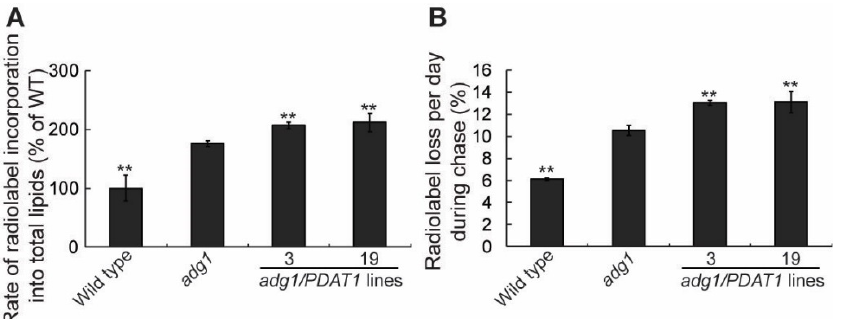
Figure 3. Overexpression of PDAT1 enhances both fatty acid synthesis and turnover in adg1 . ( A ) Rate of 14 C-acetate incorporation into total leaf lipids. ( B ) Radiolabel loss during 3 d of chase following 1 h of pulse with 14 C-acetate. Asterisks indicate statistically significant differences from adg1 based on Student’s t test ( P < 0.01).